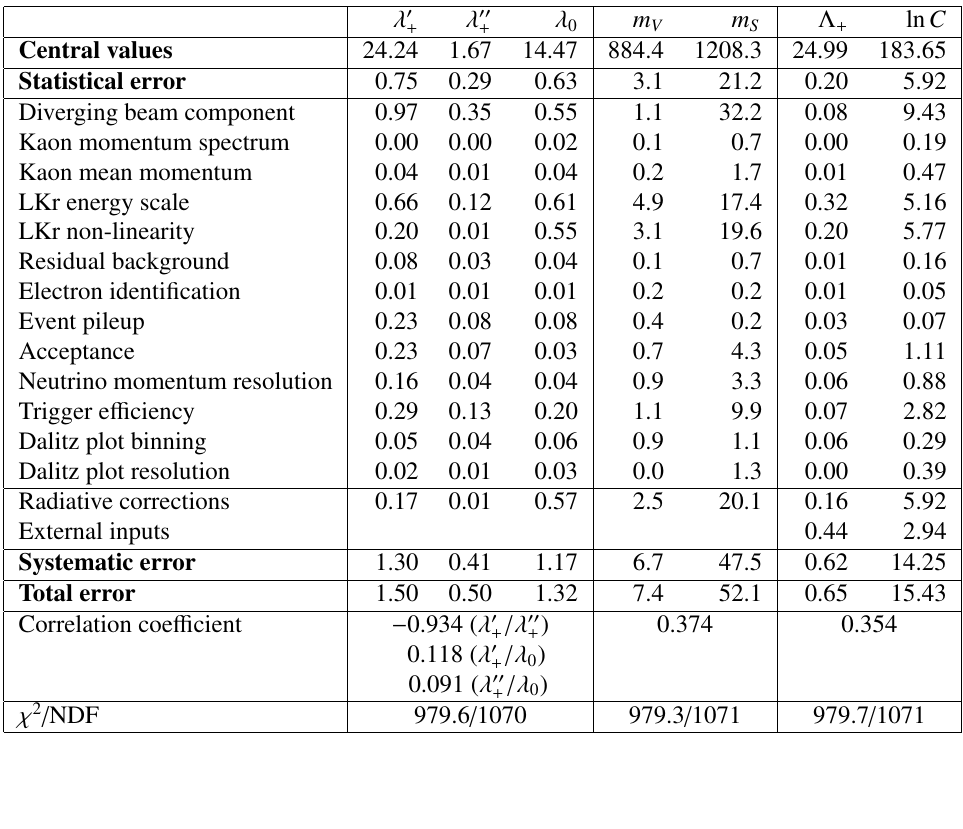
analysis. The correlations include both statistical and l 3 , λ 0 , Λ + and ln C values and errors are 10 − 3 . The units of , λ ′′ + + m V and m S values and errors are MeV / c 2 .